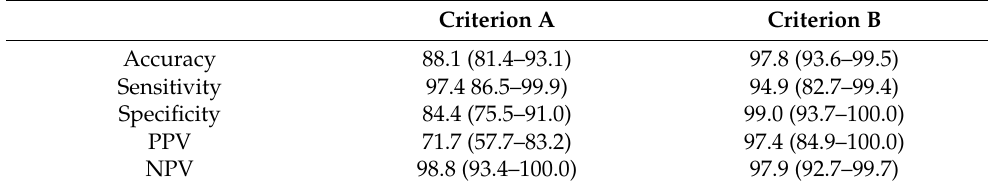
Table 3. Diagnostic accuracy for each case.